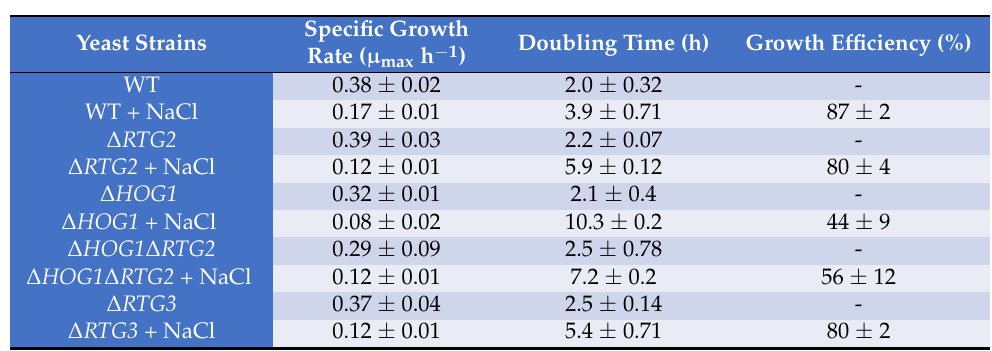
Table 1. Growth parameters of reported yeast strains in the absence and in the presence of sodium